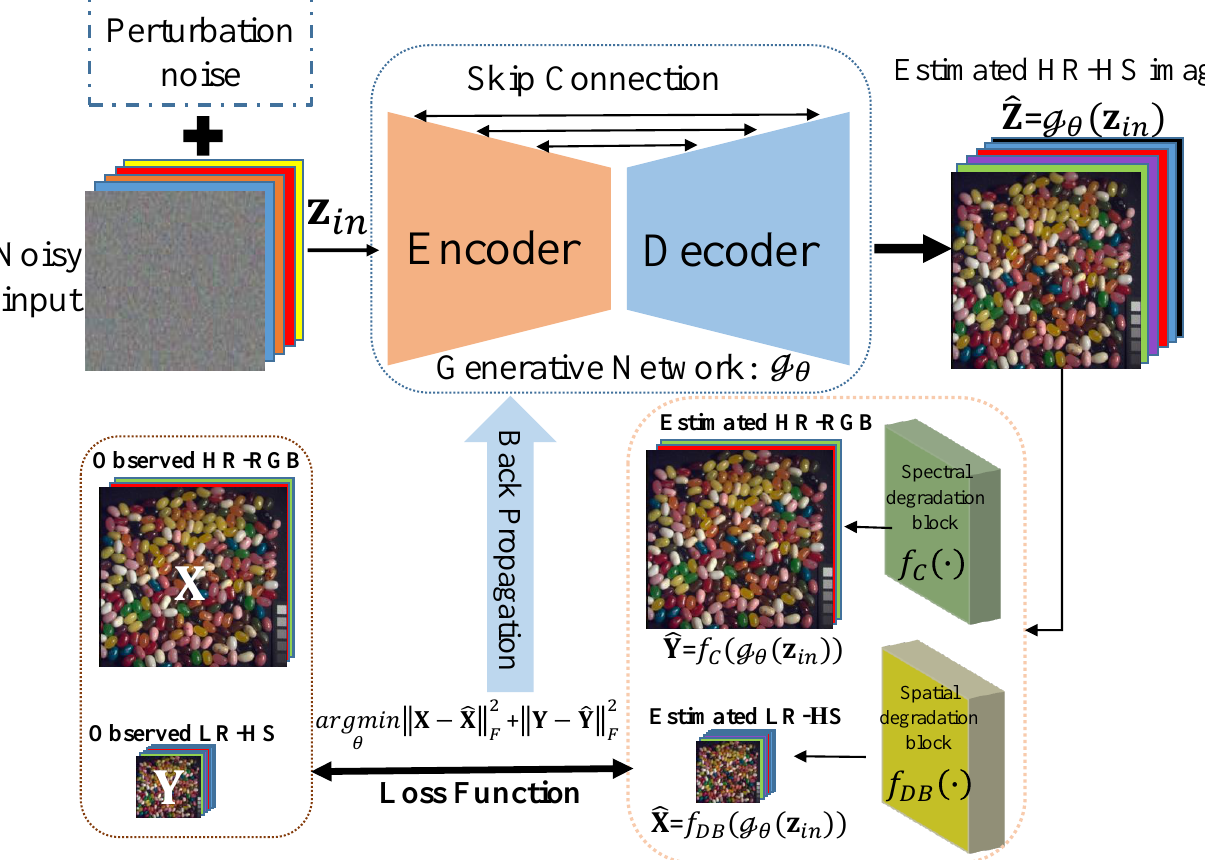
Figure 1. Conceptual diagram of the proposed DUFL method. An encoder-decoder-based generative neural network is used for modeling the rich spatial and spectral structures of a latent HR-HS image, and two parallel specifically designed convolutional blocks are used for approximating the spatial and spectral degradation models. Then the proposed framework is trained with the observations (LR-HS and HR-RGB